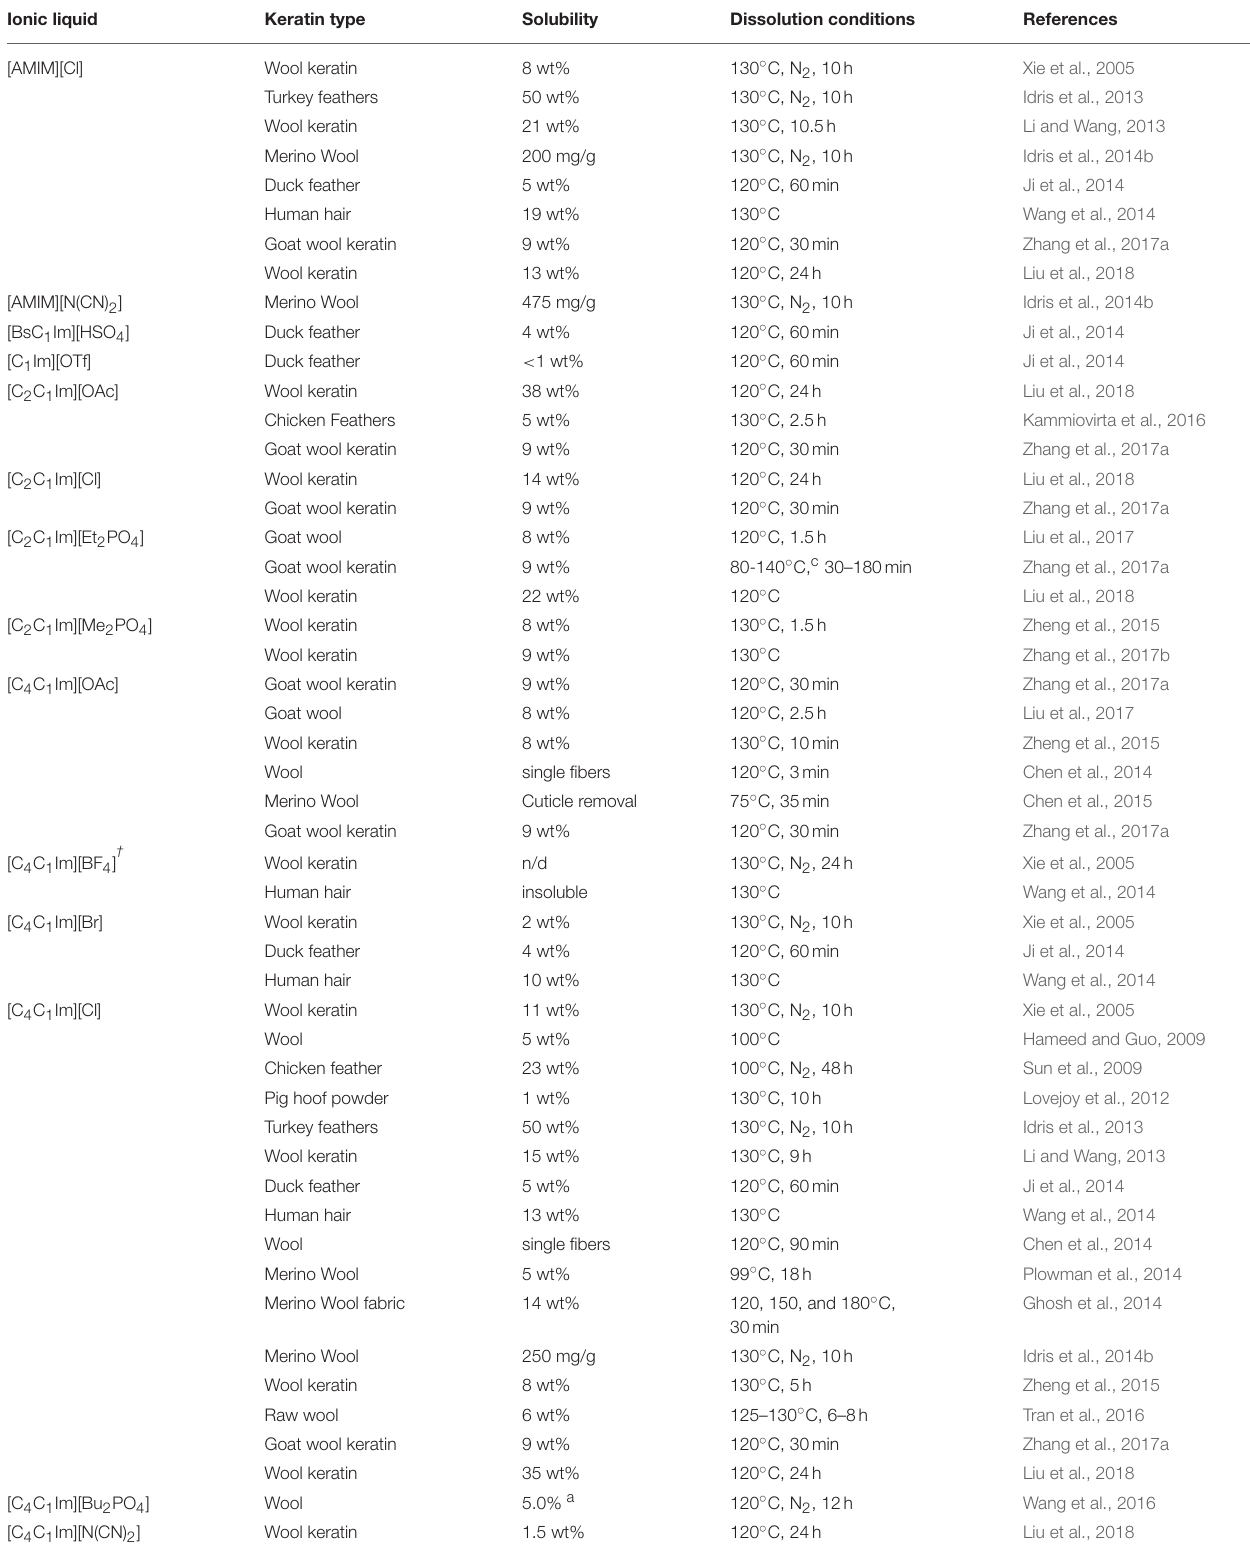
TABLE 1 | Summary of keratin solubility in selected ionic